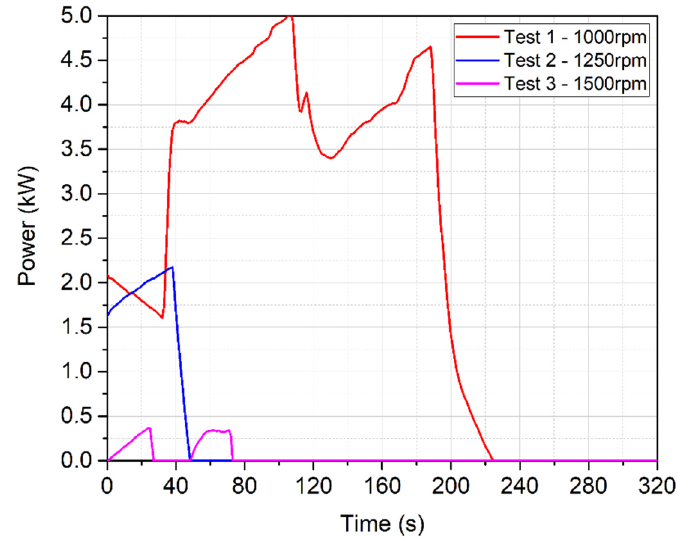
Figure 10. Theoretical power consumption of the EGH to achieve the SCR light-off temperature of 220 °C at 1000 rpm, 1250 rpm and 1500 rpm.